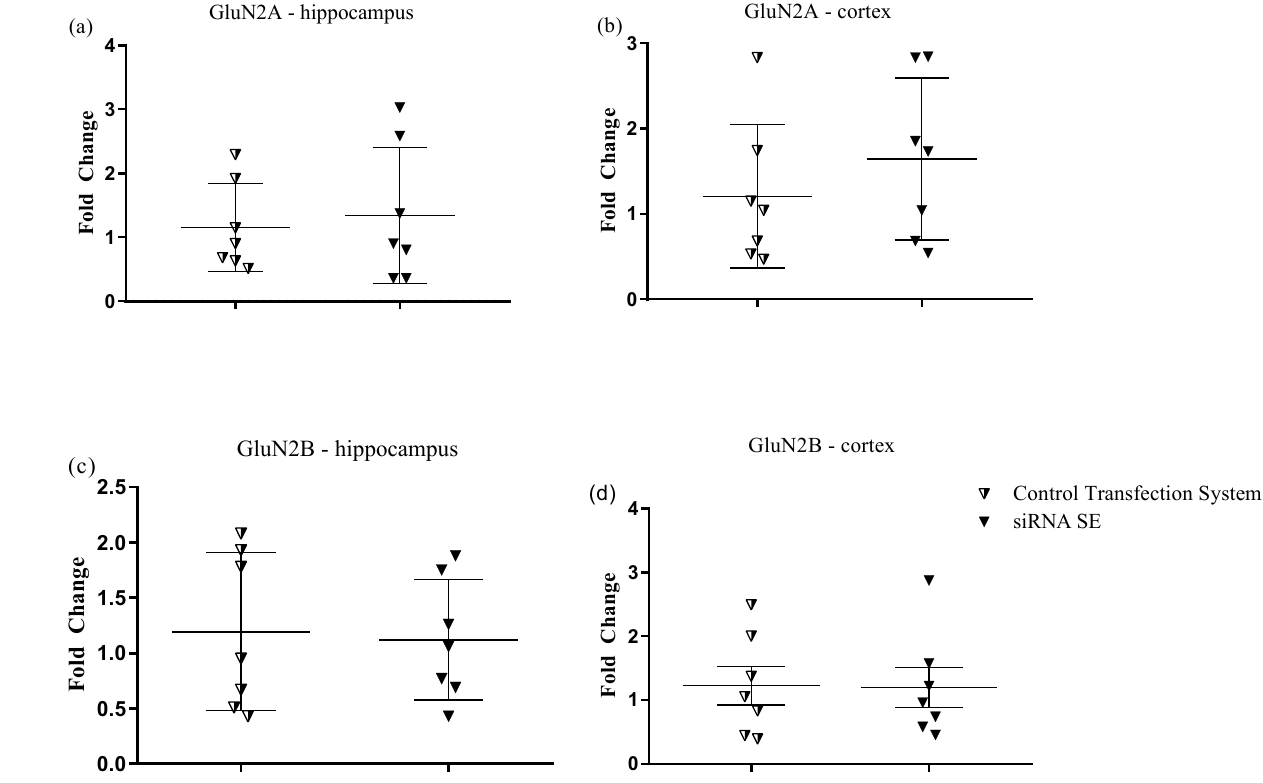
Figure 2. Relative gene expression of the GluN2A/2B gene normalized with GAPDH, compared to controls. Bars show the fold change (2 − ∆∆ Ct ) average for each group. Statistical analysis was performed using two-way ANOVA, t -test, and Shapiro–Wilk test. Animal groups were divided as follows: CONTROL TRANSFECTION SYSTEM SE (intranasal treatment with transfection system/SE induction after 14 days of intranasal treatment) and siRNA SE: (intranasal treatment with siRNA/SE induction after 14 days of intranasal treatment). ( a ) GluN2A—Hippocampus; ( b ) GluN2A—Hippocampus; ( c ) GluN2B—Hippocampus; ( d ) GluN2B—Cortex.